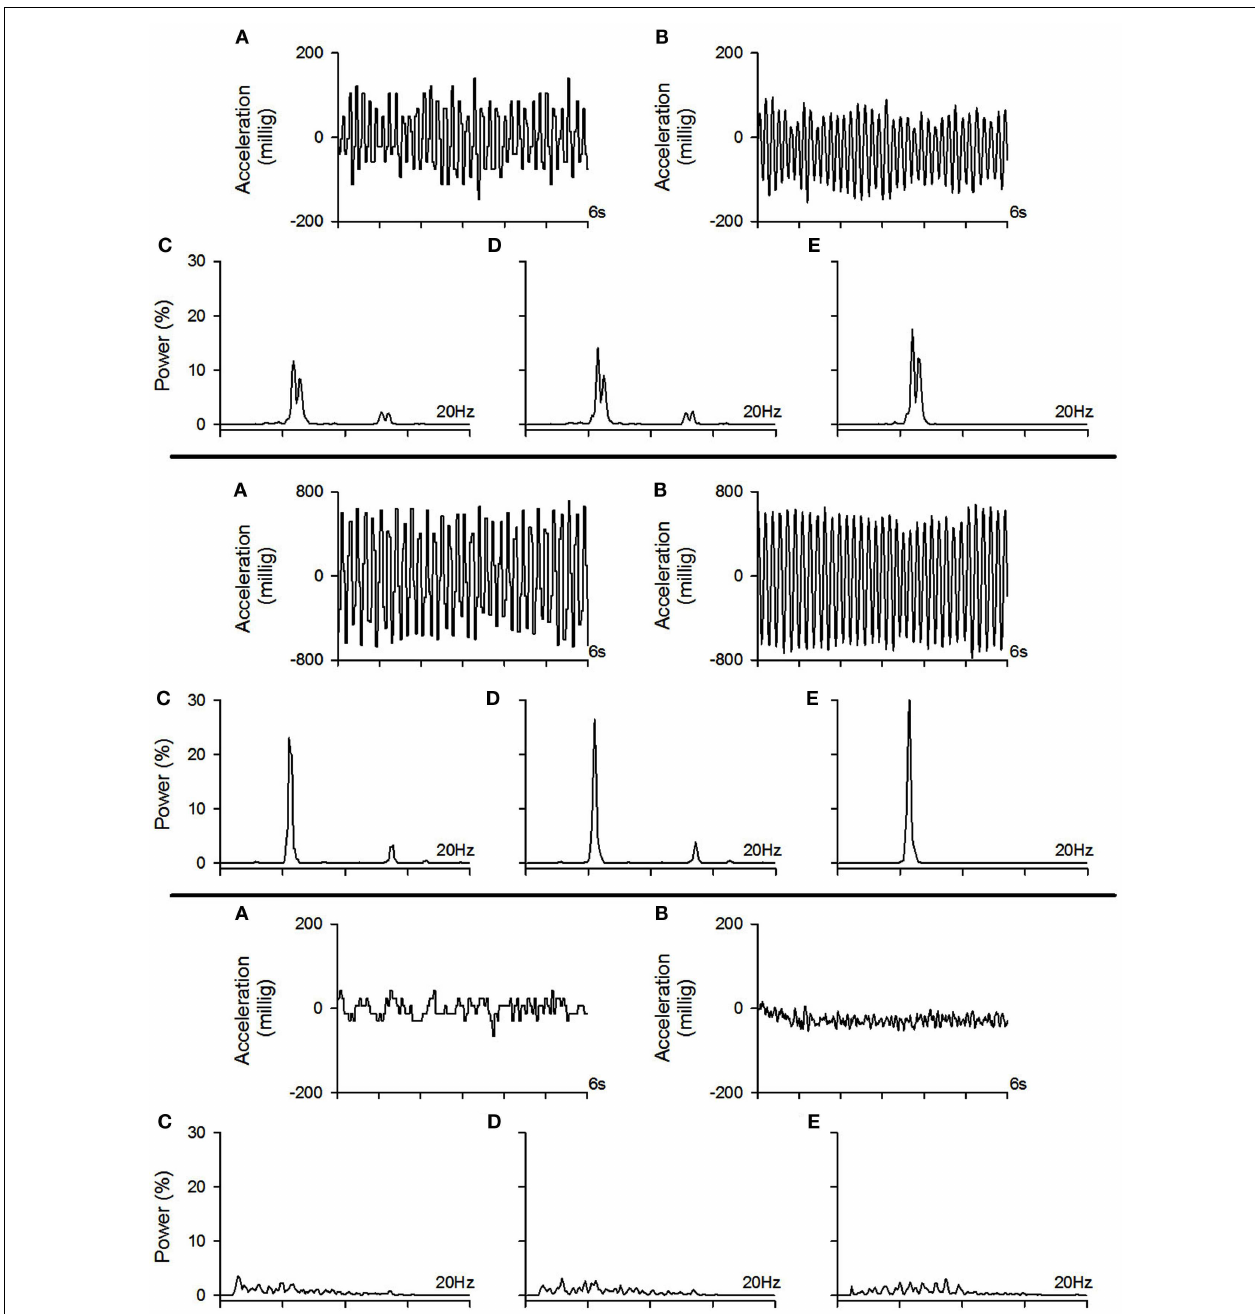
recorded with the accelerometer, (C) power spectrum of the tremor trace recorded with the smart phone which was calculated with the algorithms implemented within the smart phone, (D) power spectrum of the tremor trace recorded with the smart phone which was calculated offline using our laboratory software, (E) power spectrum of the tremor trace recorded with the accelerometer which was calculated offline using our laboratory